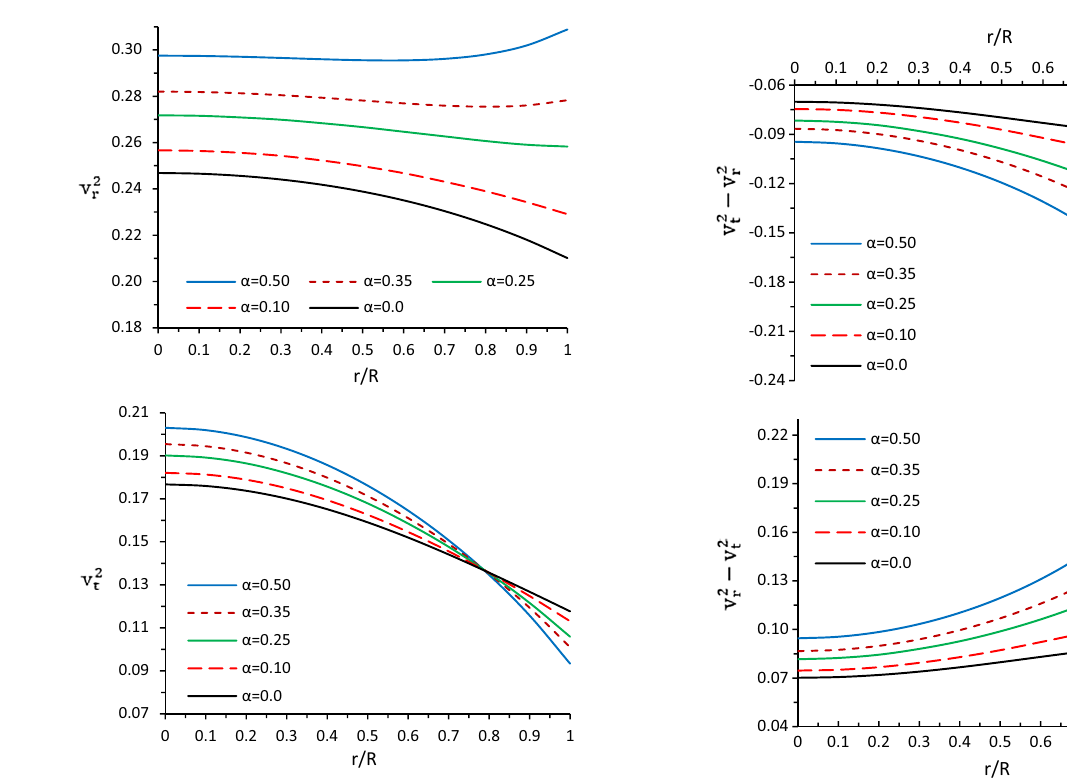
Fig. 6 The variation of stability factors v 2 t − v 2 r (top) and v 2 r − v 2 t (bottom) verses radial coordinate r / R . For plotting of this figure we have employed same data values as used in Fig.